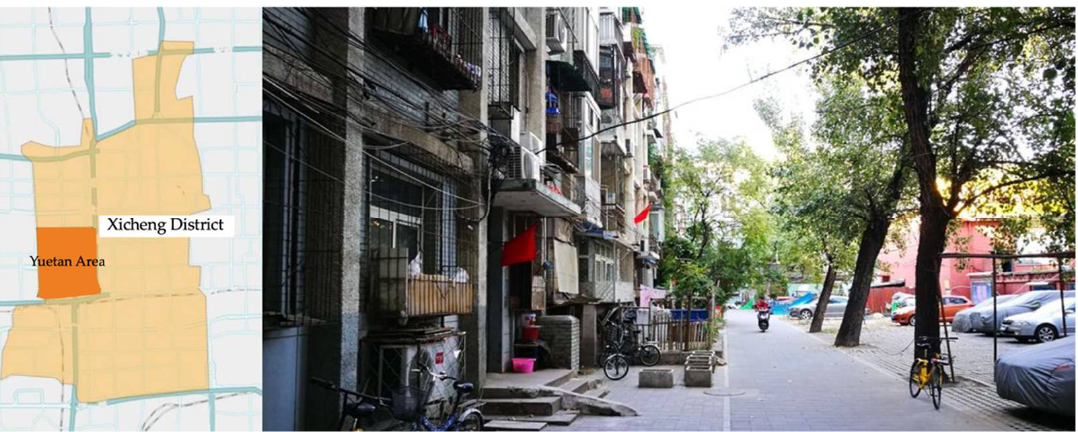
Figure 1. Location and neighborhood scenario of Yuetan Area.